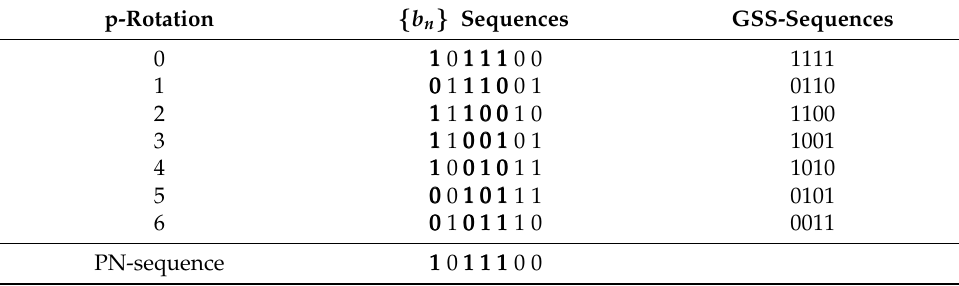
Table 1. Family of generalized sequences for p ( x ) = x 3 + x +